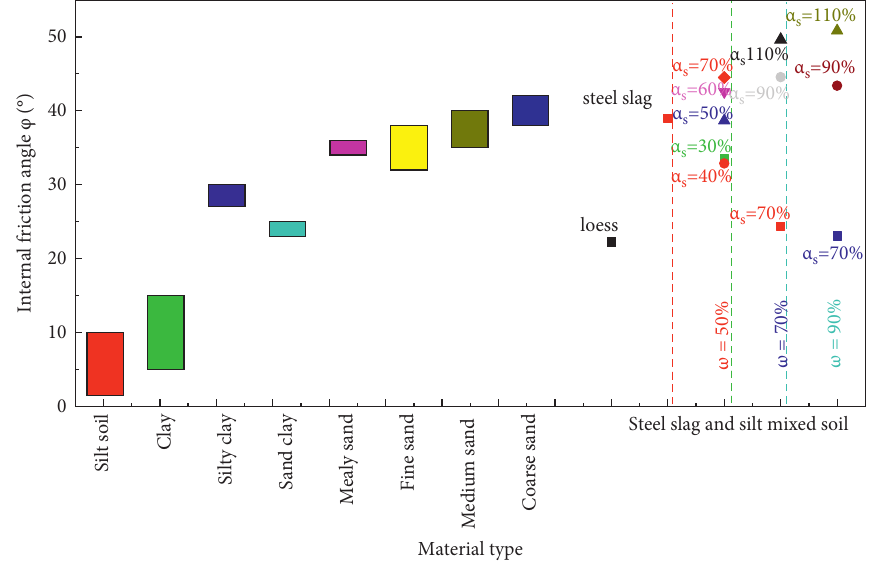
Figure 17: Internal friction angle of mixture and traditional